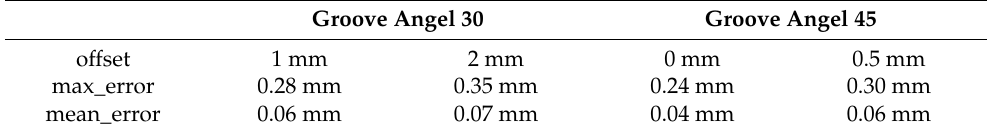
Figure 10. Offset prediction after filtering: ( a ) the welding torch moves along the seam; ( b ) the welding torch and welding seam are offset by 1 mm; ( c ) the welding torch and welding seam are offset by 0.5 mm; ( d ) the welding torch and welding seam are offset by 2 mm. Table 4. Errors of prediction after filtering.